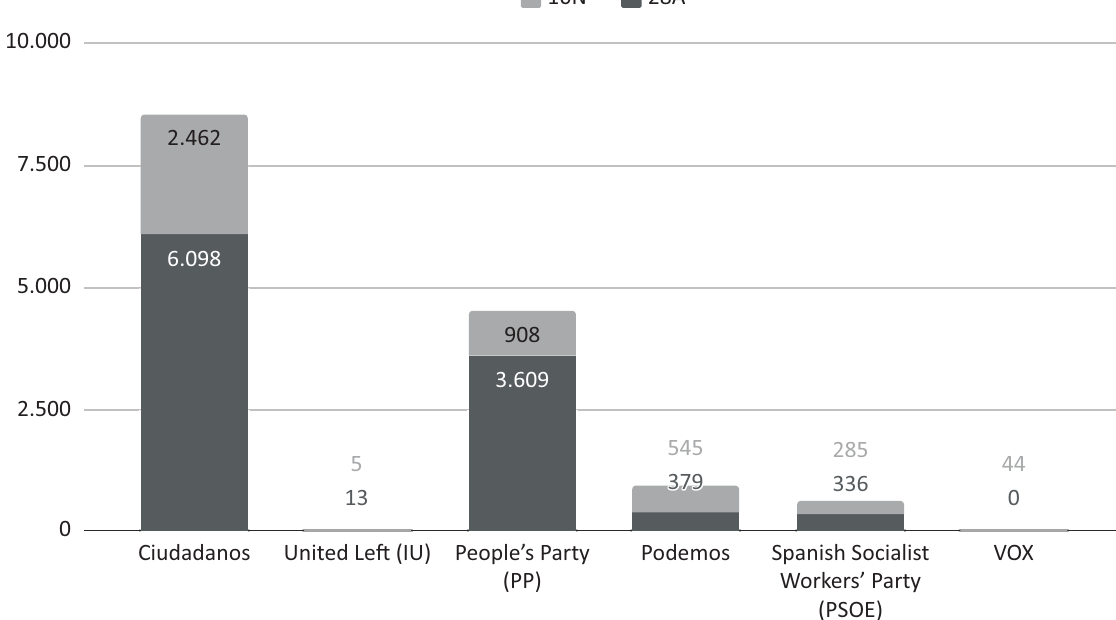
Figure 1. Ads posted by the parties during the 28 April and 10 November election campaigns (2019). Media and Communication, 2021, Volume 9, Issue 1, Pages